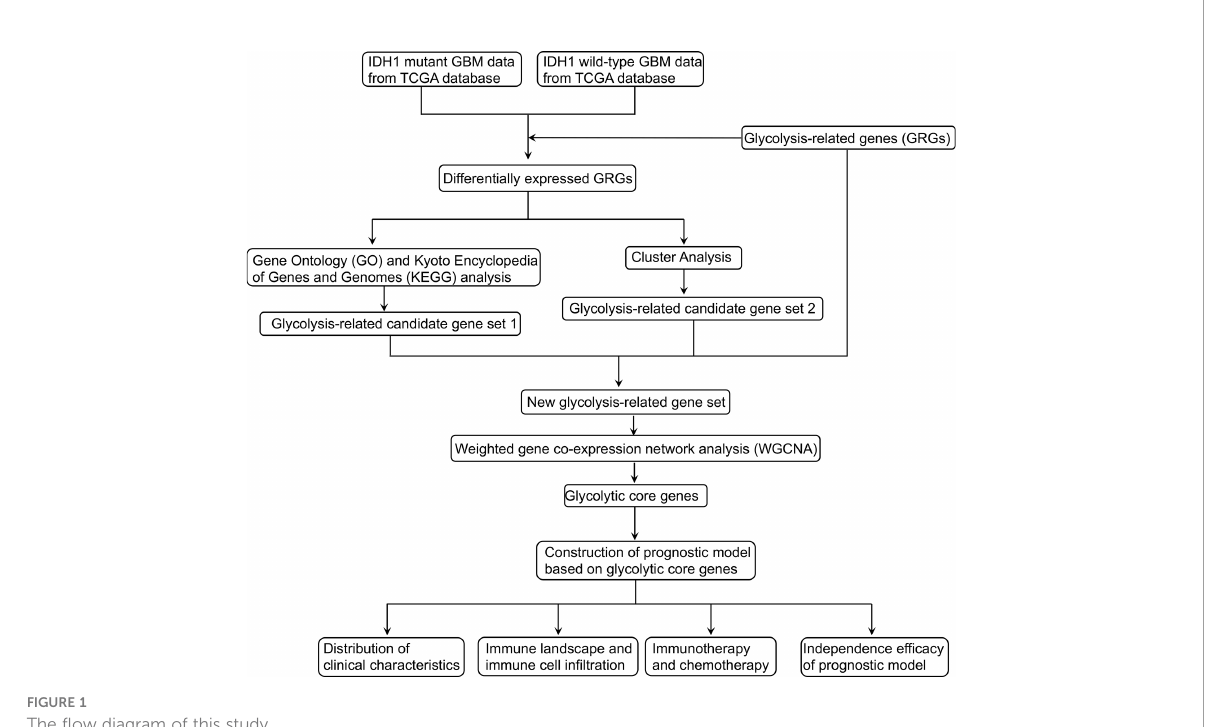
FIGURE 1 The fl ow diagram of this